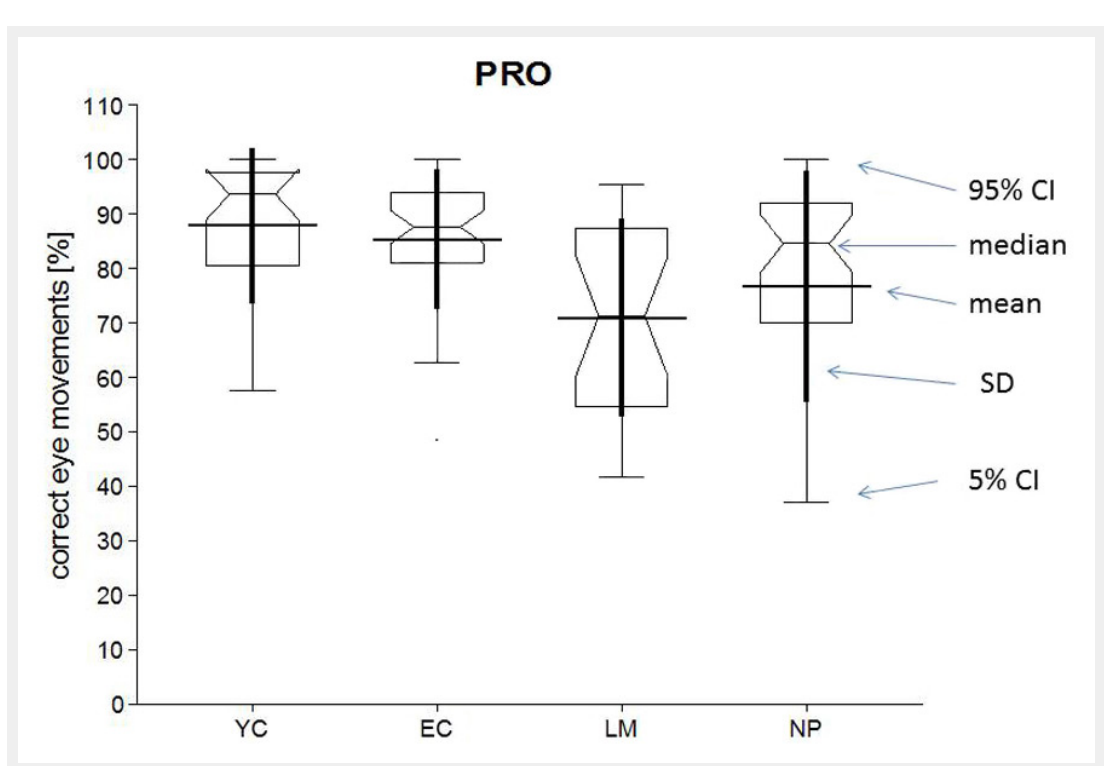
Figure 1 Evaluation of all prosaccades for all groups. The percentage of correctly performed eye movements is presented; boxes indicate the distribution of the data include mean and SD (thick line), median, confidence intervals (5%, 95%) and outliers (single dots). EC = elderly comparison group; LM = patients at the Department of Legal Medicine; NP = patients at the Department of Neurology; YC = young comparison